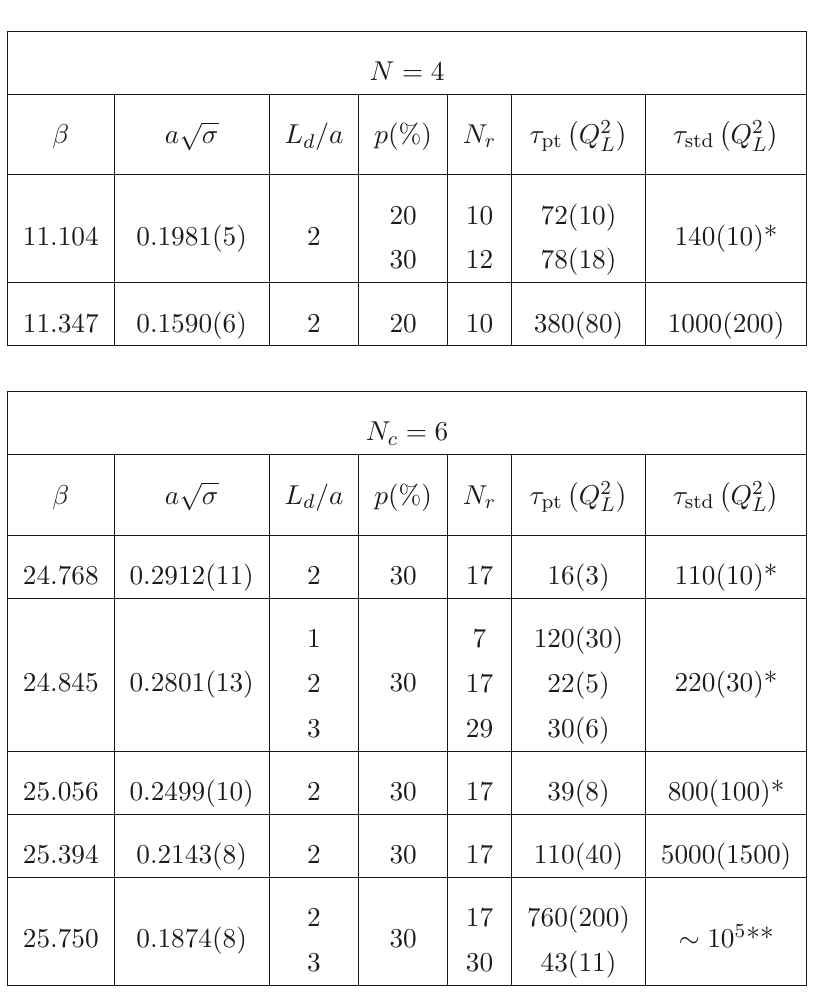
obtained by using the standard and the L are taken from ref. [13], where the procedure ∗